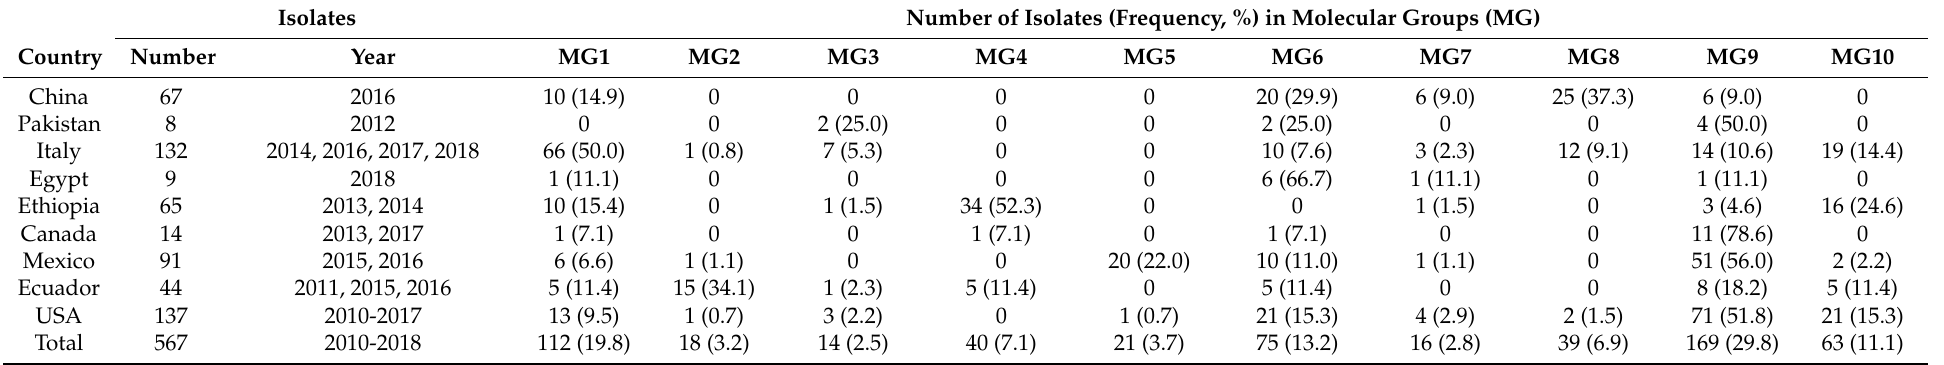
Table 1. The numbers and frequencies, sampling years, and moleular groups (MG) of the Puccinia striiformis f. sp. tritici isolates from nine countries in 2010–2018.